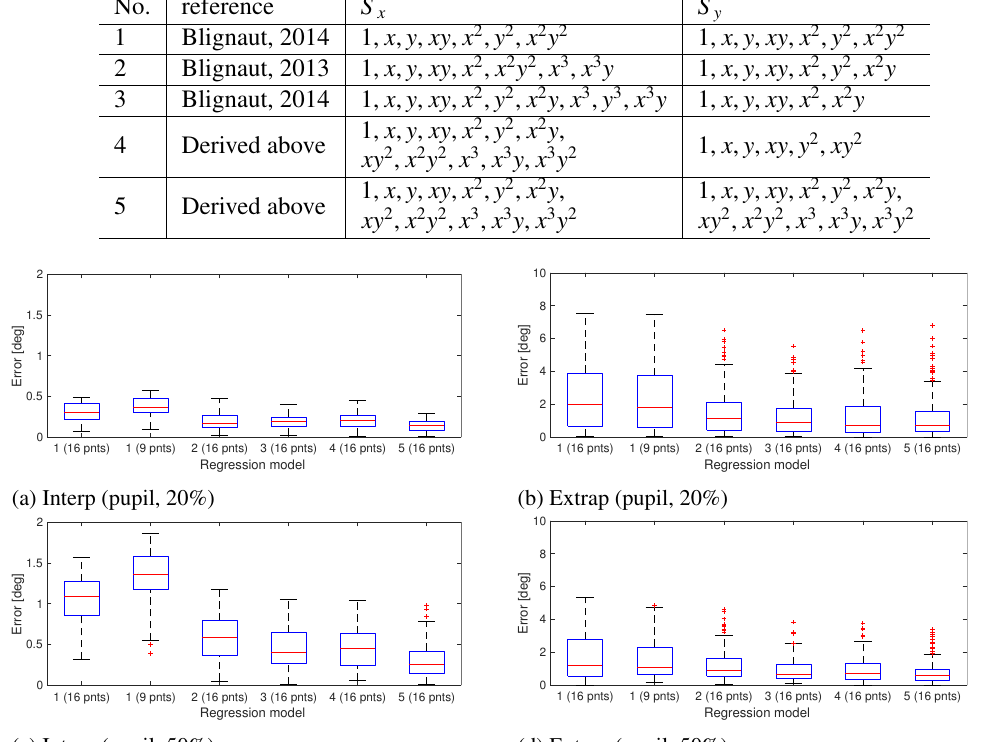
Summary of models tested in the simulation. Functions are shown with only their terms without coe ffi cients.